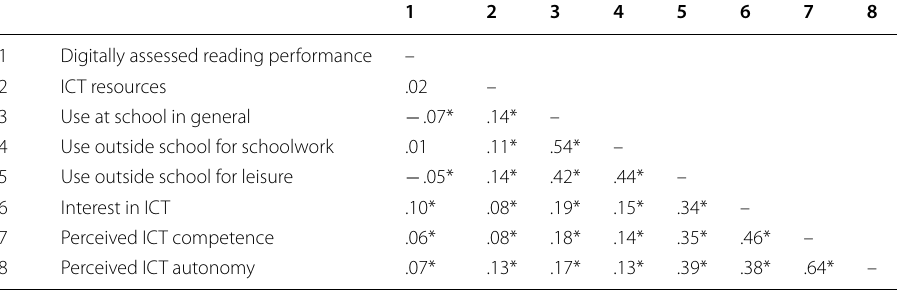
Table 2 Correlations between digitally assessed reading performance, ICT resources, ICT use, and ICT